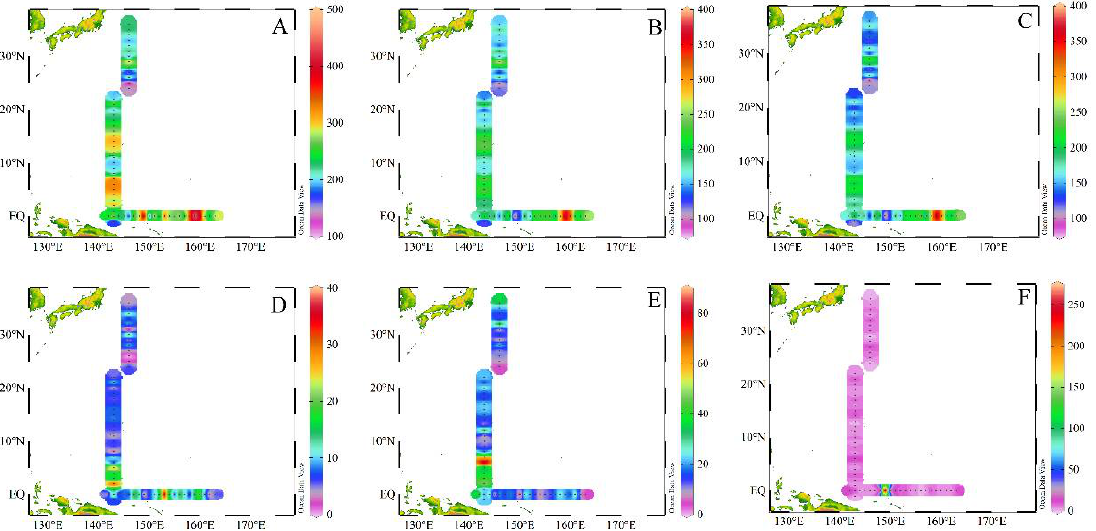
Figure 4. The horizontal surface distribution of zooplanktons in the survey area (ind./m 3 ). ( A – F ) Species abundance, Arthropoda, Copepods, Chaetognaths, Chordata, and Larvae.